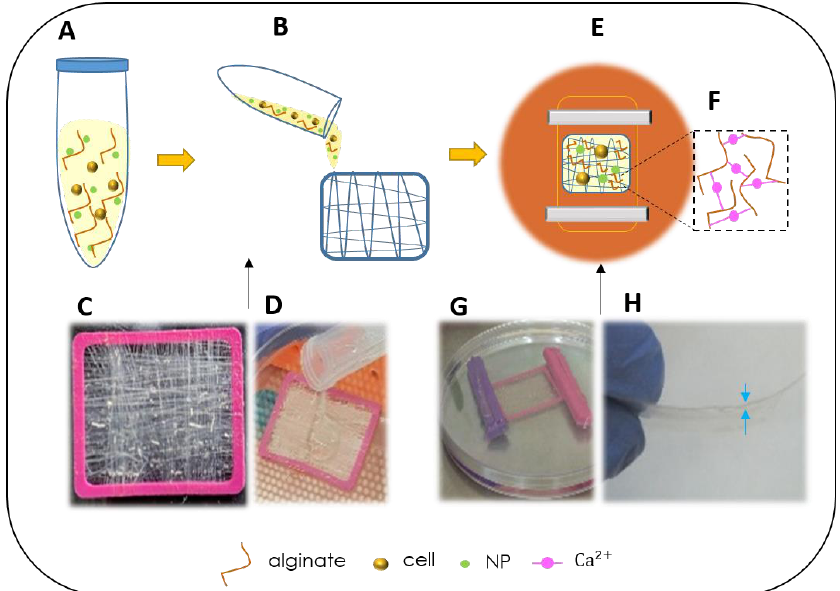
Figure 1. Biocomposite preparation. Alginate solution was mixed with cells or NPs ( A ) or combined with collagen fibers ( B ). The collagen fibers are arranged around a PLA frame to create a multidirectional net ( C , D ). The frame is then introduced into a dialysis membrane and submerged in a calcium solution to form the alginate hydrogel ( E – G ). The film of biocomposite is ready to use ( H